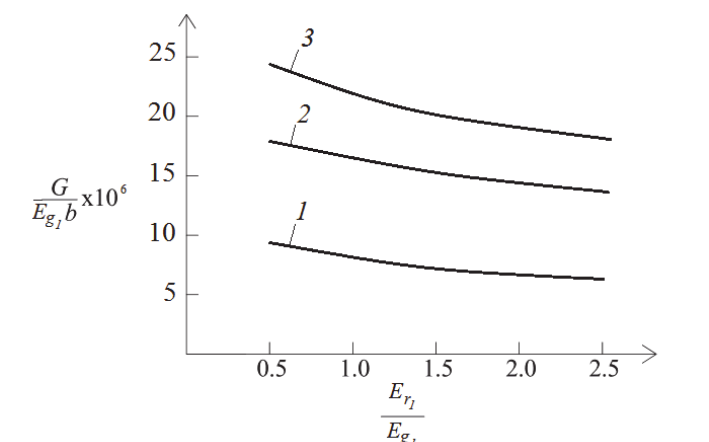
Figure 7: The strain energy release rate in non-dimensional form presented as a function